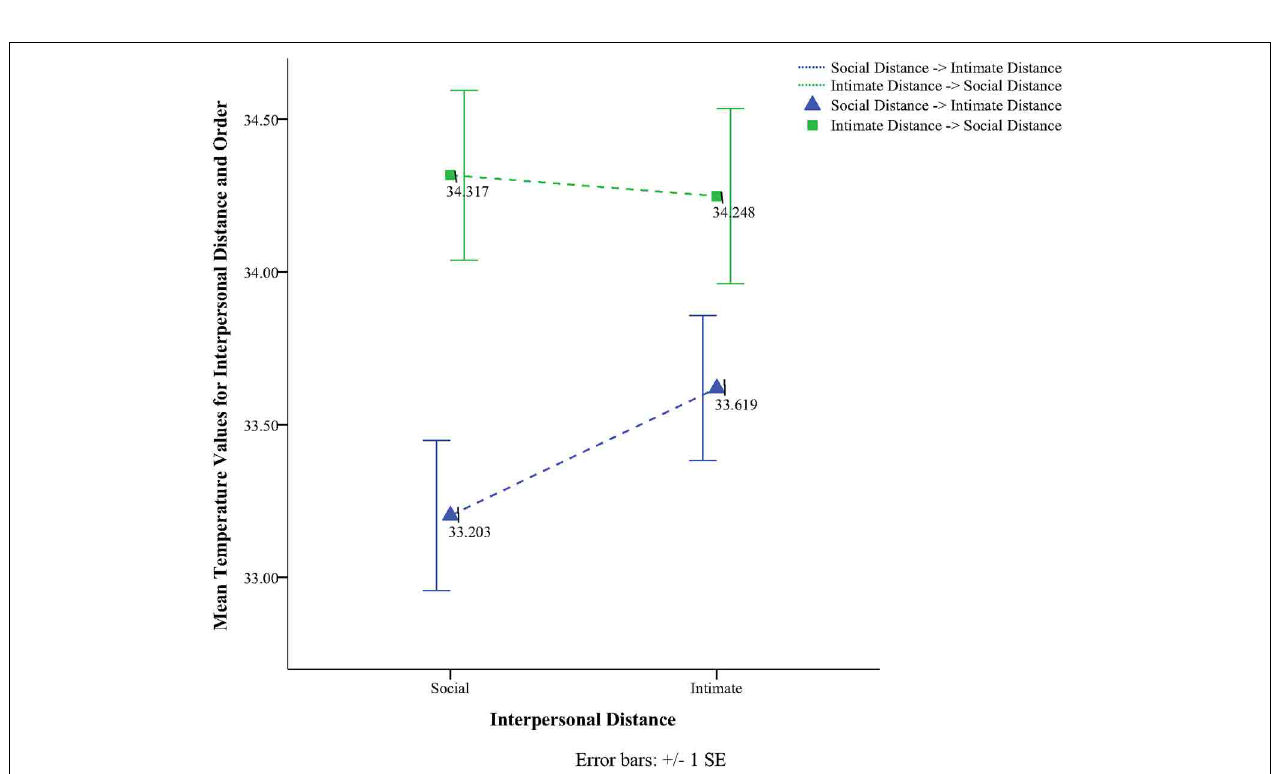
FIGURE 2 | Line graph representing the interaction effect between interpersonal distance and